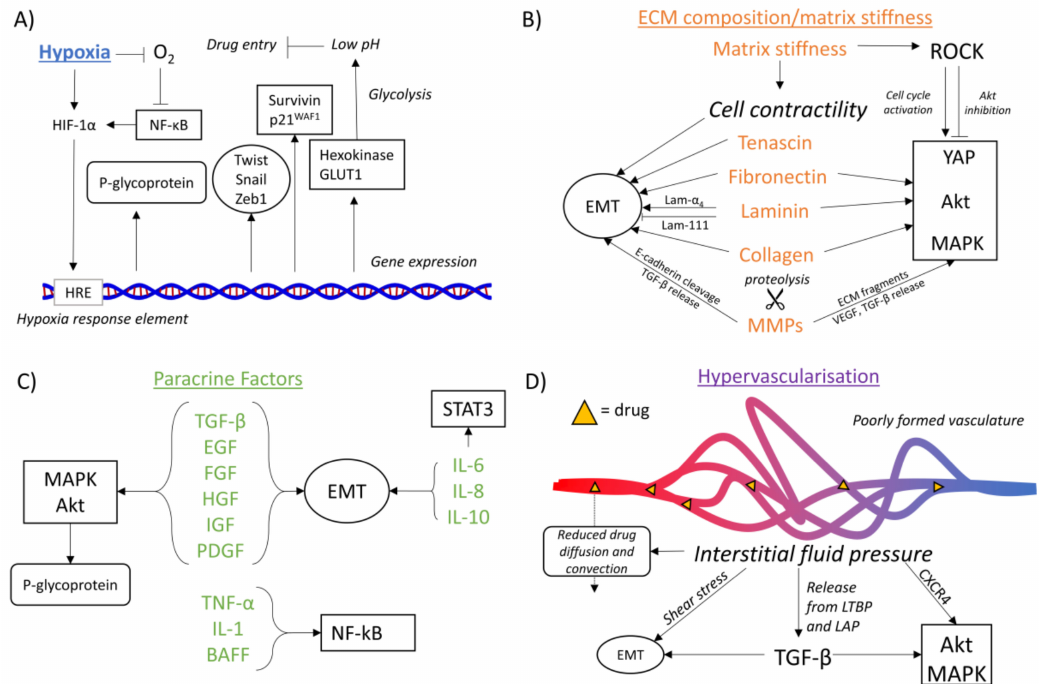
Figure 3. Effects of the microenvironment on mechanisms of chemoresistance. ( A ) Hypoxia. A lack of oxygen leads to the stabilization of HIF-1 α (hypoxia inducible factor 1 alpha), either directly or through NF- κ B-mediated (nuclear factor kappa-light-chain-enhancer of activated B cells) gene expression. HIF-1 α binds to the hypoxia response element (HRE), upregulating P-glycoprotein (drug availability), the transcription factors Twist, Snail, and Zeb1 (EMT) and survivin and p21 WAF1 (cyclin-dependent kinase inhibitor 1) (oncogenic signaling). Also upregulated are hexokinase and GLUT1 (glucose transporter 1), which promote glycolysis, leading to a reduced external pH and inhibition of drug entry. ( B ) ECM composition and matrix stiffness. The ECM proteins tenascin, fibronectin, laminin, and collagen all affect the EMT (epithelial–mesenchymal transition), although different laminin α chains have different effects. Fibronectin, laminin, and collagen also modulate the oncogenic signaling pathways of YAP, Akt, and MAPK. MMPs (matrix metalloproteinases) act to release paracrine factors such as TGF- β , which regulates both EMT and oncogenic pathways. In addition, MMPs can cleave E-cadherin to promote EMT and ECM fragments to promote oncogenic pathways. Matrix stiffness promotes cell contractility, which leads to EMT, as well as promoting Rho-associated coiled coil-containing protein kinase (ROCK) activation, which has differing effects on oncogenic pathways. ( C ) Paracrine factors. The factors TGF- β , EGF, FGF, HGF, insulin-like growth factor (IGF), and platelet derived growth factor (PDGF) both promote EMT, and the MAPK and Akt pathways. MAPK and Akt also activate P-glycoprotein. Interleukins 6 and 8 promote STAT3 signaling and EMT. TNF- α , IL-1 and B cell-activating factor (BAFF) promoter NF- κ B signaling. ( D ) Hypervascularization. The interstitial fluid pressure generated by hypervascularization can promote EMT through shear stress, oncogenic signaling pathways through C-X-C chemokine receptor type 4 (CXCR4) activation, and TGF- β release, which promotes EMT and oncogenic pathways. Interstitial fluid pressure reduces drug diffusion and convection. In all cases, rounded rectangle = drug availability, circle = EMT, rectangle = oncogenic signaling